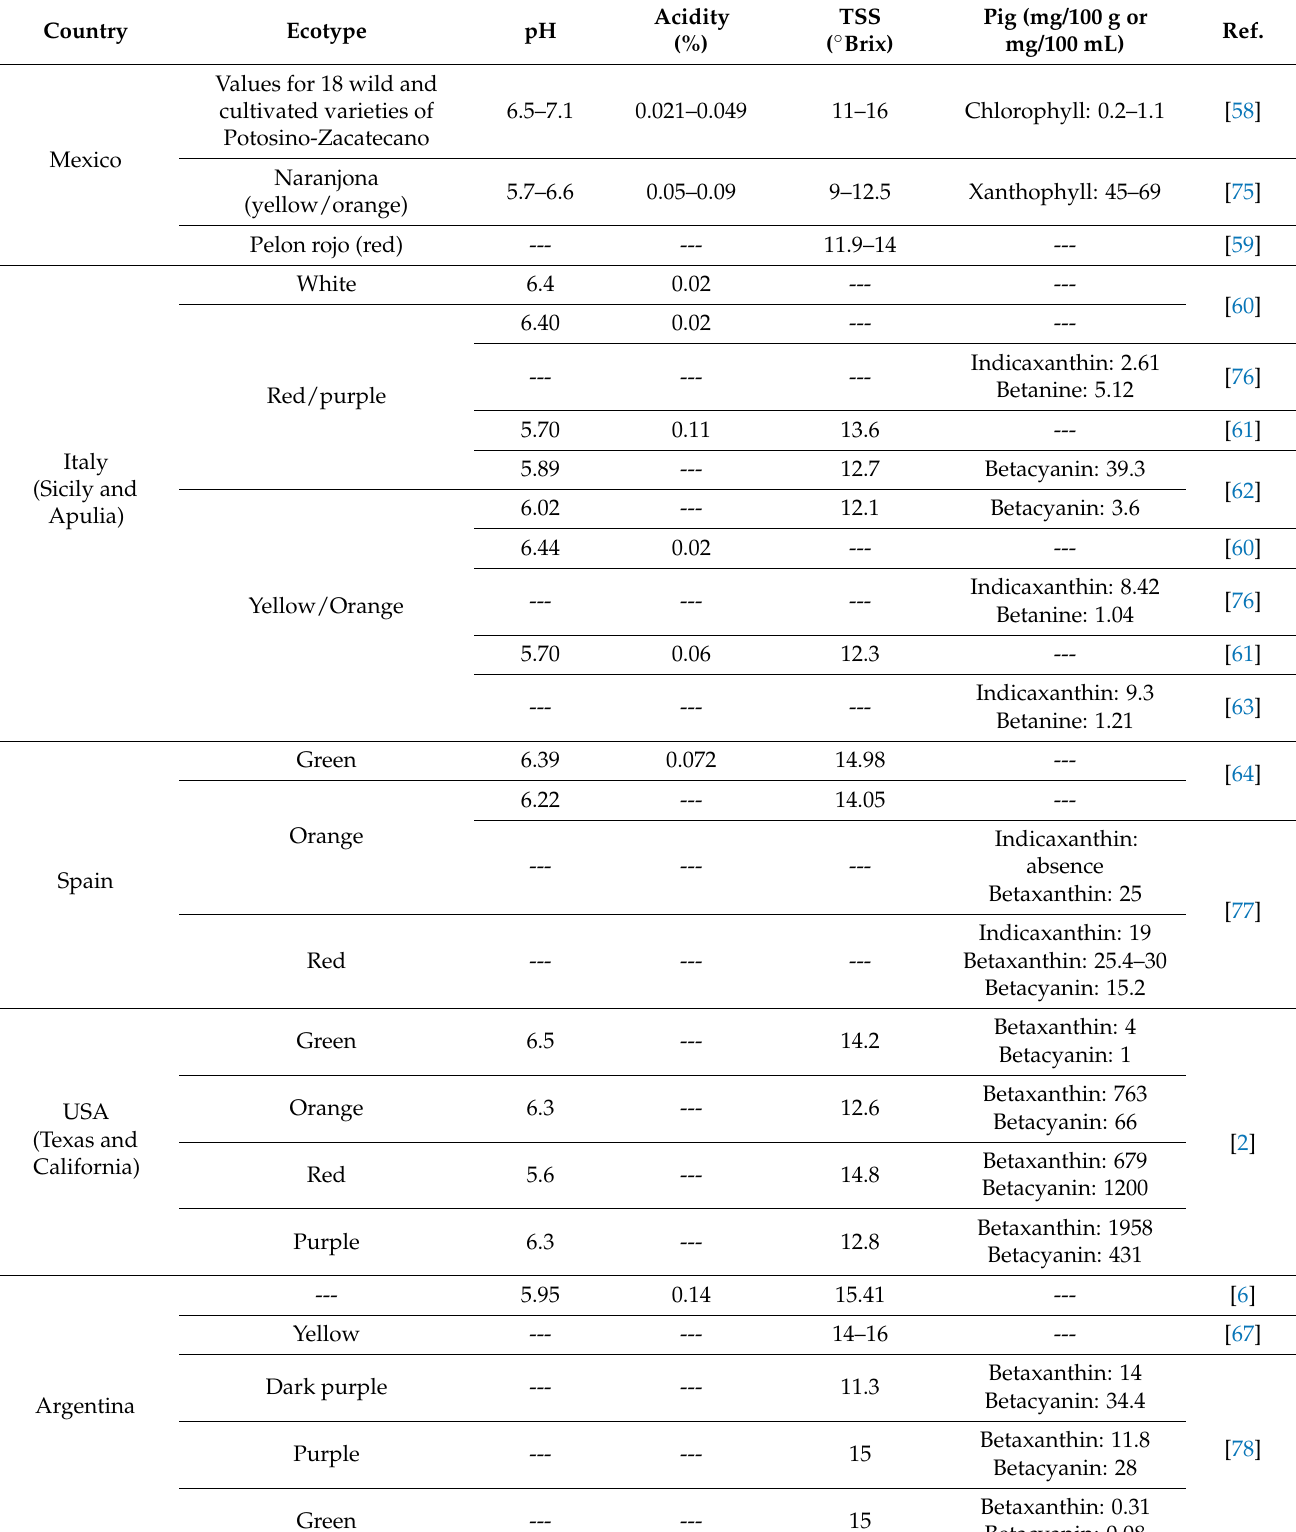
Table 3. Physicochemical composition of several PP ecotypes in different regions of the